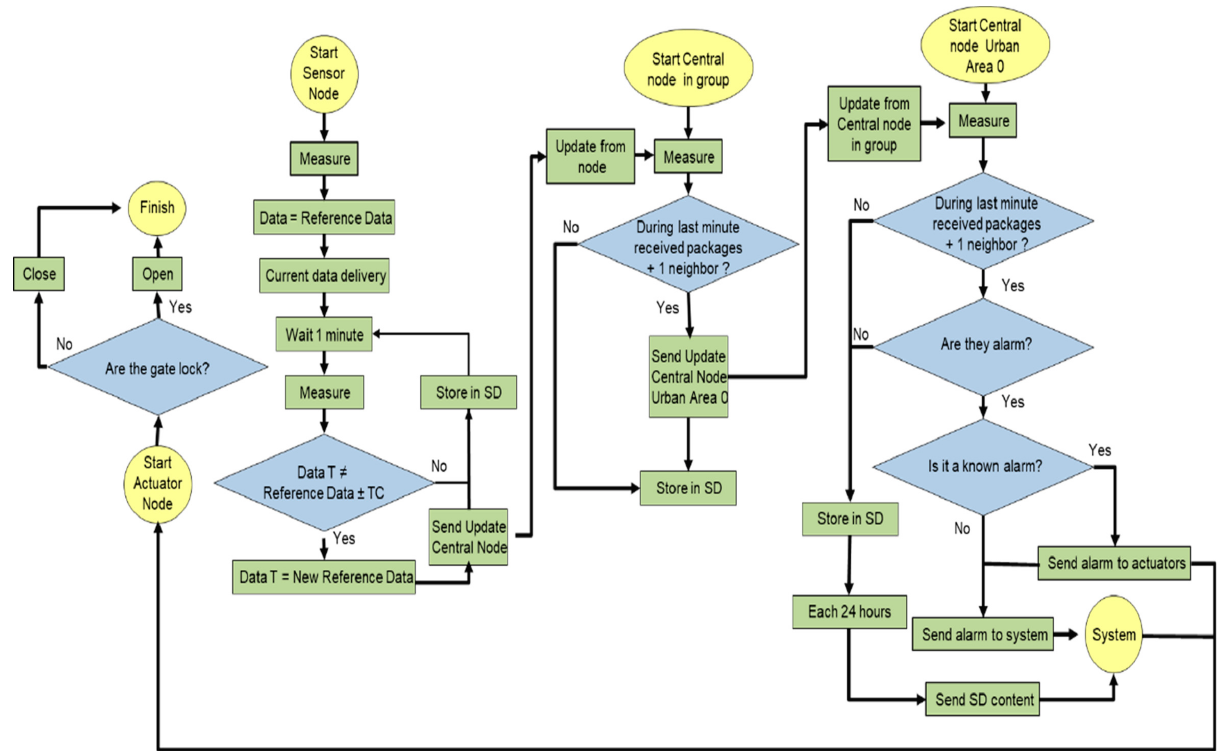
Figure 5. Algorithm for node groups.